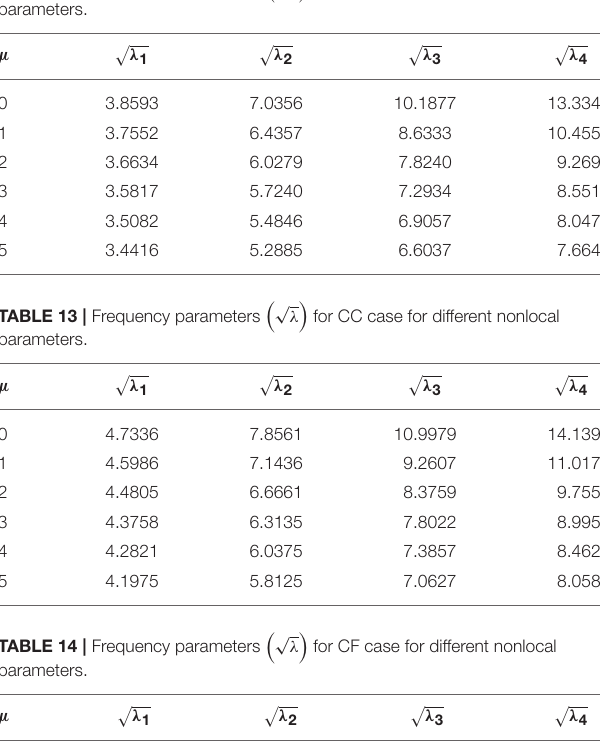
TABLE 11 | Frequency parameter parameter. µ